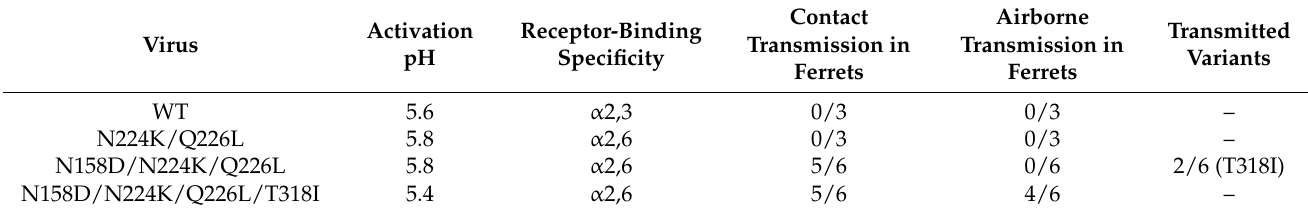
Table 9. Phenotypes of A/California/04/2009 (H1N1) viruses bearing A/Vietnam/1203/04 (H5) HA1 variants in ferrets [52]. Contact Airborne Activation Receptor-Binding Transmitted Virus Transmission in Transmission in pH Specificity Variants Ferrets Ferrets WT 5.6 α 2,3 0/3 0/3 N224K/Q226L